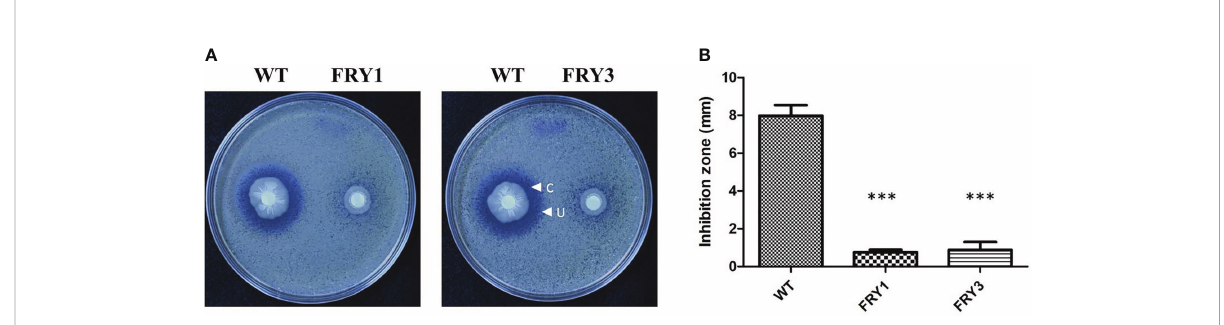
FIGURE 7 The D srf mutants reduced the inhibition activity against S. scabies . (A) Disk diffusion assay. The 10 6 spores of S. scabies PS07 were spread on YME agar plates, and a disk containing 3 m l WT or D srf mutant culture (OD 600 = 1) was put on the surface of plates. The plates were incubated at 28°C for 2 days. “ C ” represents clear inhibition zone, and “ U ” represents undifferentiated zone. (B) Graph of (A) . P values were calculated by t - test, “ *** ” represents P < 0.001 as compared to the WT.